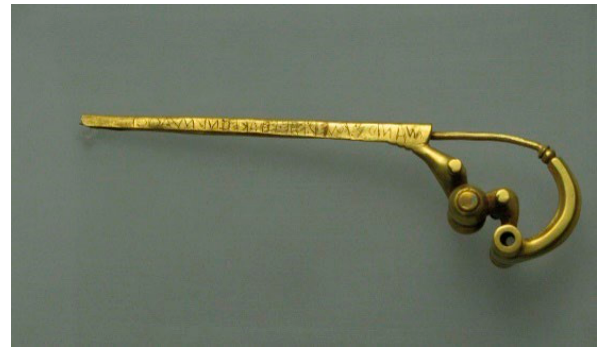
Figure 8. Fibula Prenestina 670-650 bC. Pigorini Museum Rome.